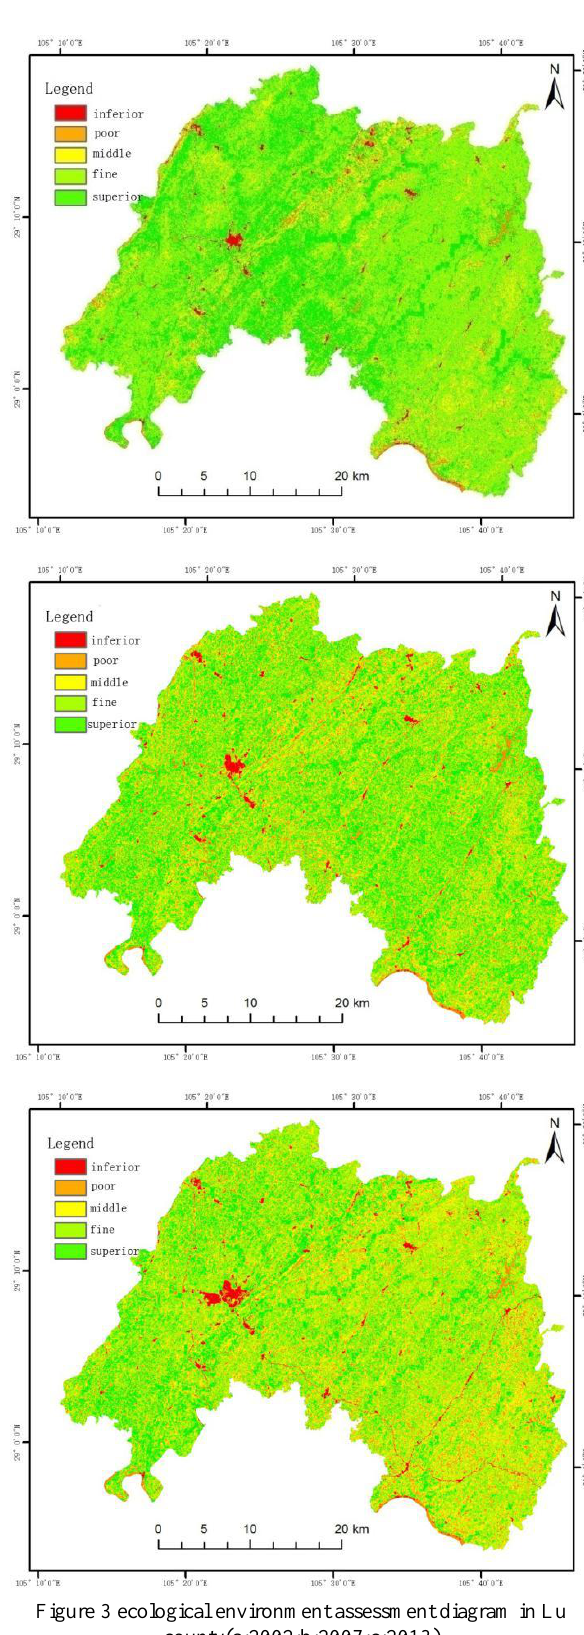
Figure 3 ecological environment assessment diagram in Lu